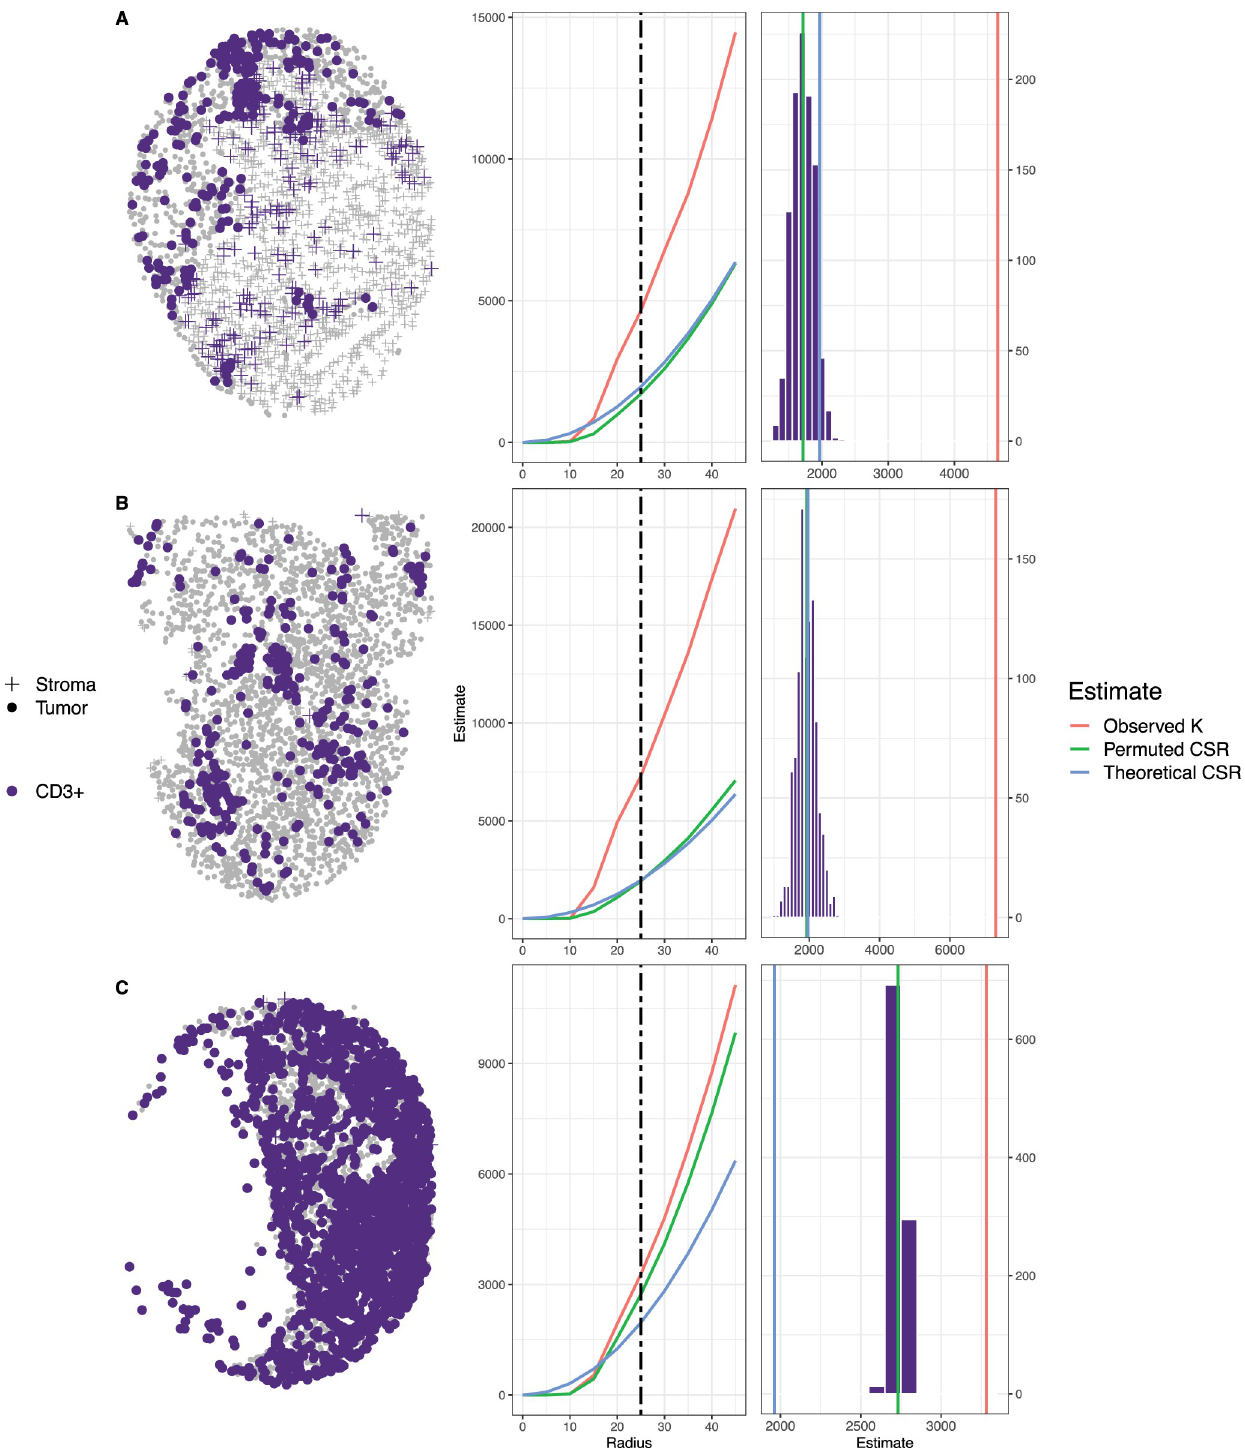
Fig 2. The empirical distribution of Ripley’s K under CSR generated by permutation with the translational edge correction for r = 50 and 100 for CD3 + cells. The observed value of Ripley’s K is represented by blue dotted line, the mean of the permutation-based CSR distribution is represented by the vertical black solid line, and the theoretical CSR computed assuming no “holes” in the tissue sample image is the vertical red line. As the level of missing cells increases (i.e., more “holes”) there is larger difference between the estimate of CSR based on theoretical computation using area and the estimate of CSR based on the mean of the empirically derived